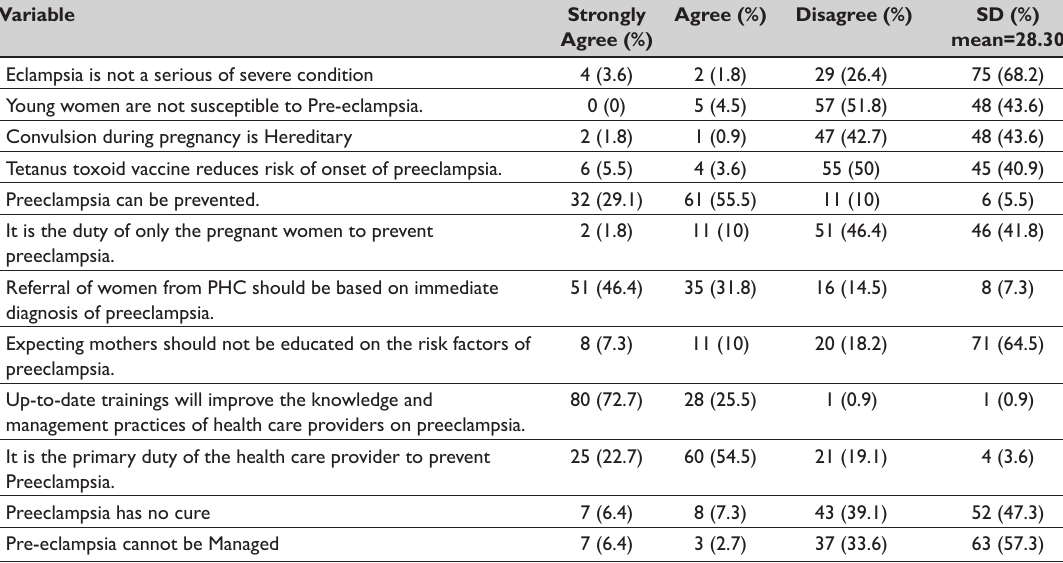
Table 4: Perceptions of Pre-Eclampsia